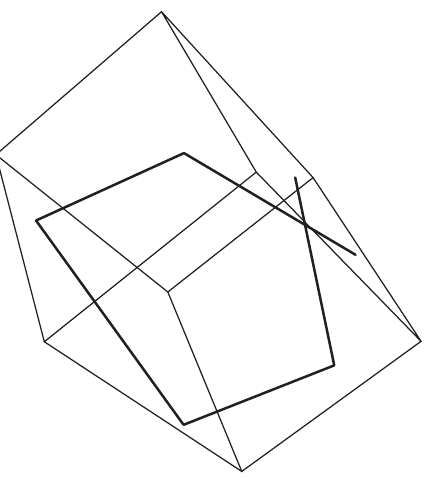
Figure 3: The Kahan’s integrator of the system (cid:7) 3.8 (cid:8) (cid:7) c 1 (cid:6) 1, c 2 (cid:6) 2, c 3 (cid:6) 3, k (cid:6) 10, and h (cid:6) 1, x 1 (cid:7) 0 (cid:8) (cid:6) x 2 (cid:7) 0 (cid:8) (cid:6) x 3 (cid:7) 0 (cid:8) (cid:6) 1 (cid:8) .